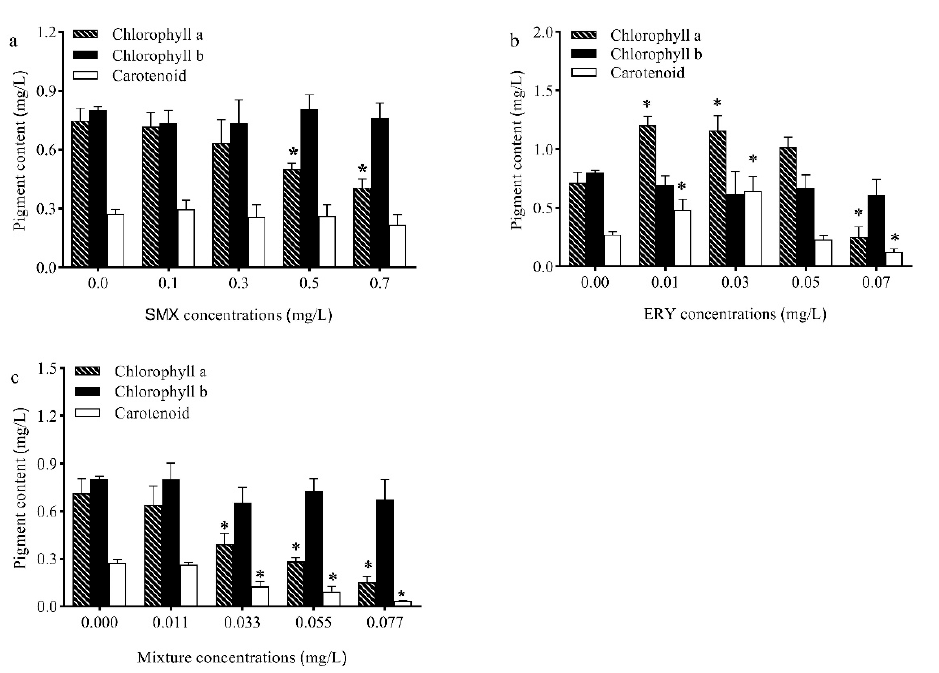
Figure 2. Effects of ( a ) SMX, ( b ) ERY, and ( c ) their mixture on the total chlorophyll and carotenoid contents of R. subcapitata . Data are presented as mean values ± standard deviation (n = 3). The asterisk (*) indicates a significant difference ( p < 0.05) between control and treatments.